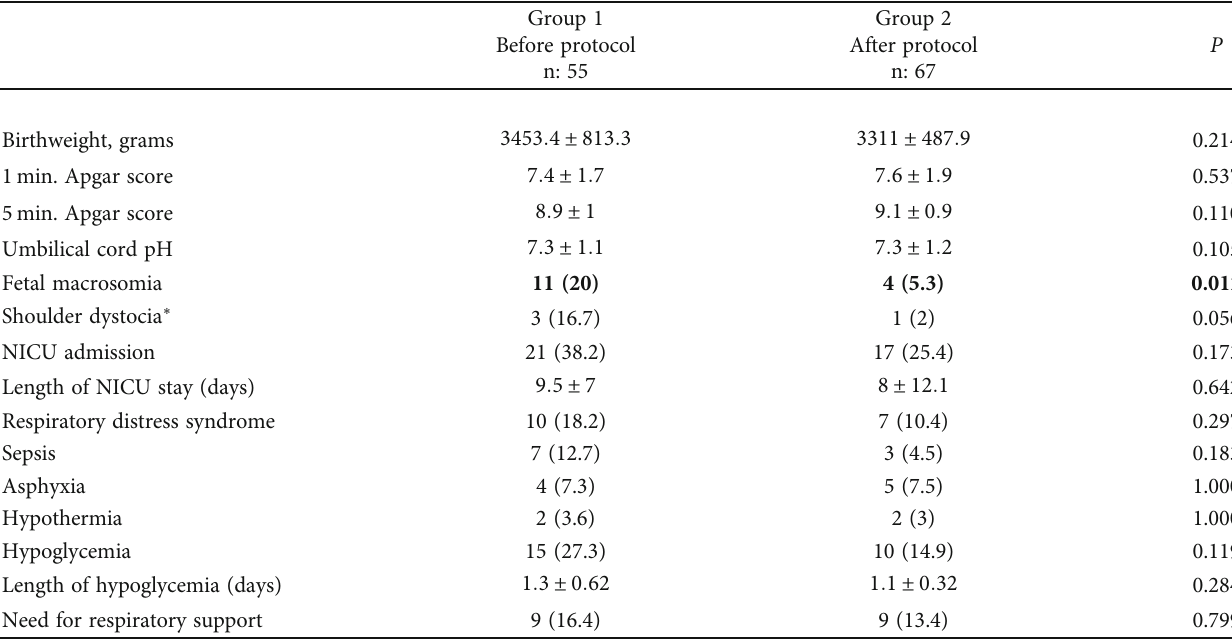
Table 4: Neonatal outcomes of infants delivered by women with diabetes in pregnancy who delivered before (group 1) and after (group 2) the introduction of a standardized multidisciplinary management